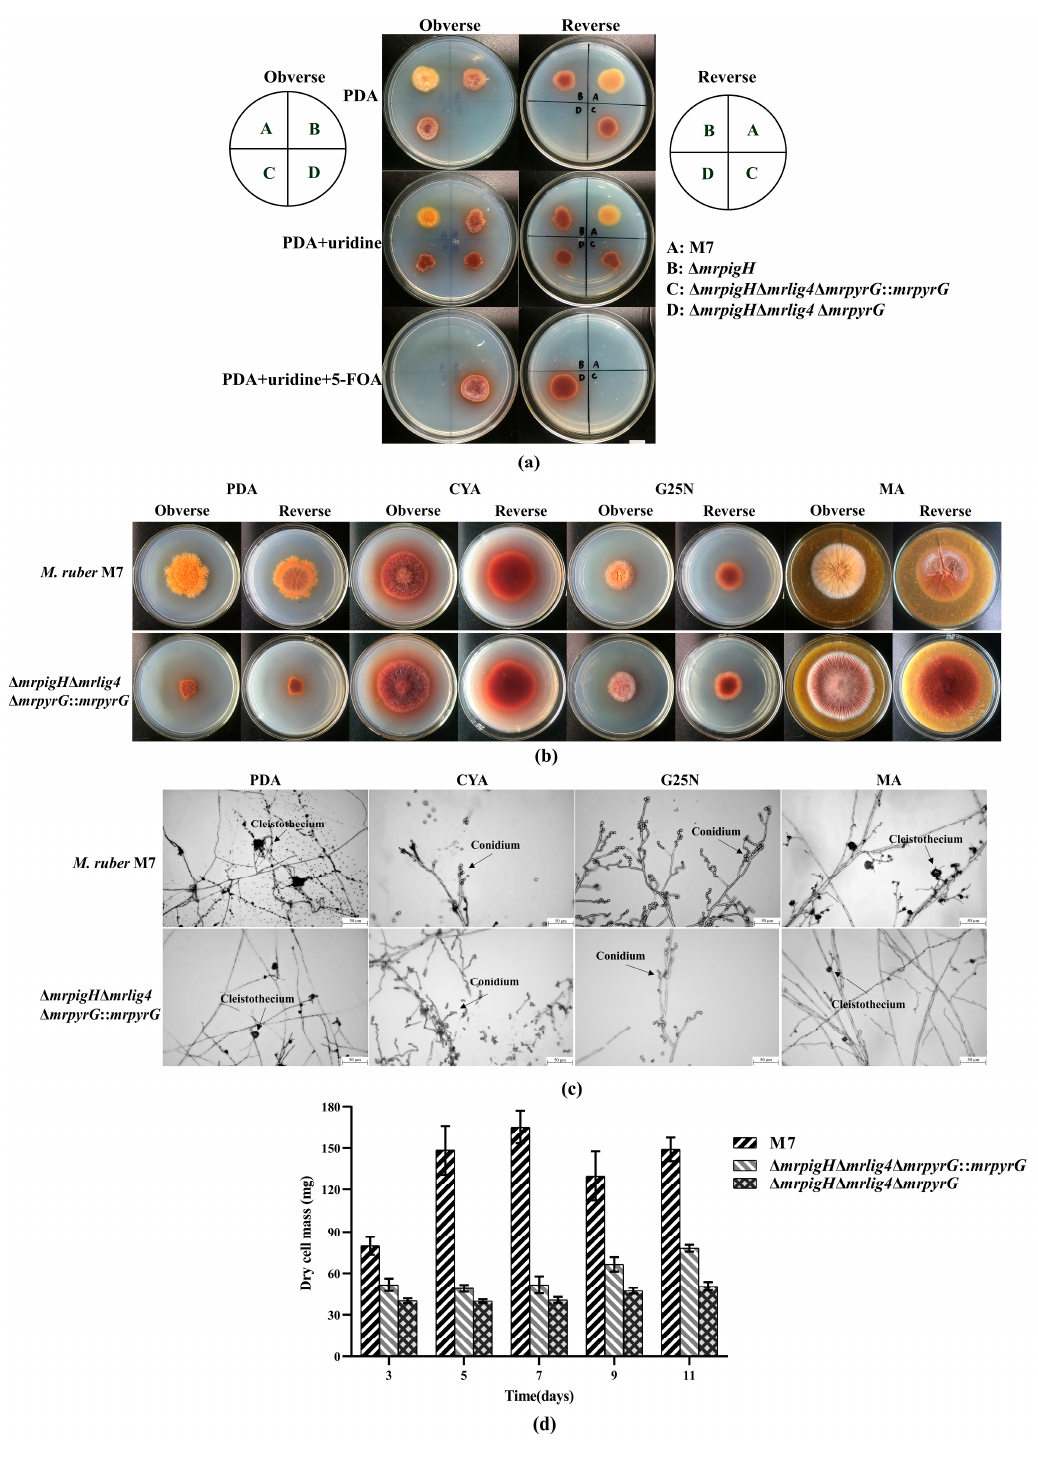
Figure 2. Morphologies and biomasses of mrpigH mutants and M. ruber M7. ( a ) Growth of M. ruber M7 and mrpigH mutants on PDA, PDA with 10 mM uridine, PDA with 10 mM uridine and 0.75 mg/mL 5-FOA for 5 days at 28 °C. A, M. ruber M7; B, Δ mrpigH , mrpigH was disrupted in M. ruber M7 with the hph selection marker [9]; C, Δ mrpigH Δ mrlig4 Δ mrpyrG :: mrpyrG ; D, Δ mrpigH Δ mrlig4 Δ mrpyrG ; ( b ) Colonial morphologies of M. ruber M7 and Δ mrpigH Δ mrlig4 Δ mrpyrG :: mrpyrG on PDA, CYA, MA and G25N plates for 10 days at 28 °C; ( c ) Cleistothecia and conidia formation of M. ruber M7 and Δ mrpigH Δ mrlig4 Δ mrpyrG :: mrpyrG on different plates (PDA, CYA, G25N, and MA) for 7 days at 28 °C; ( d ) Biomass (dry cell weight) of M. ruber M7 and mrpigH mutants on PDA plates at 28 °C. The error bar represents the standard deviation between the three repeats.